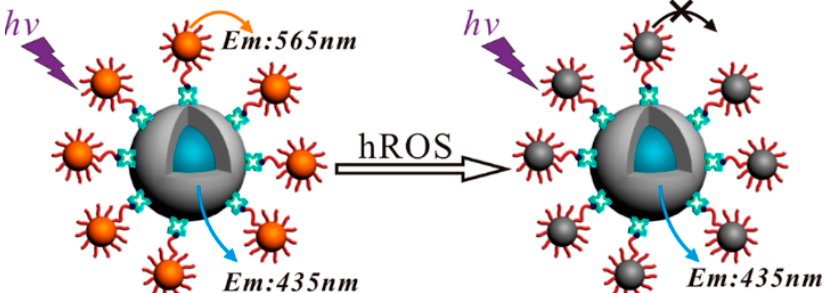
Figure 4. A fluorescent nanoplatform of AuNCs decorated silica particles for live cell imaging. Reprinted with permission [54]. Copyright 2013 American Chemical Society.